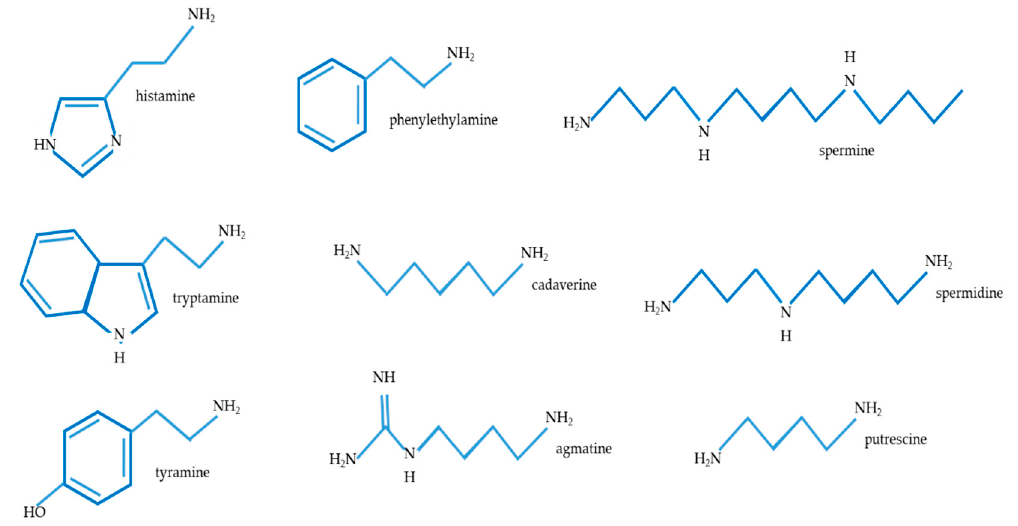
Figure 1. The molecular structures of common amines.